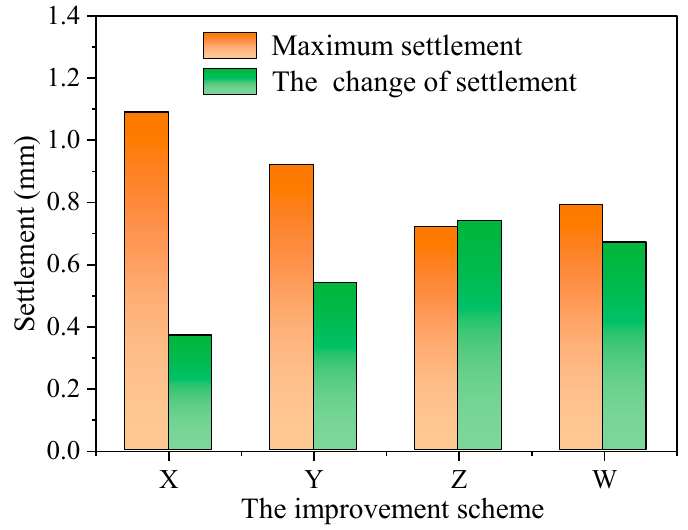
Figure 15. Changes in the maximum settlement of each improvement scheme.